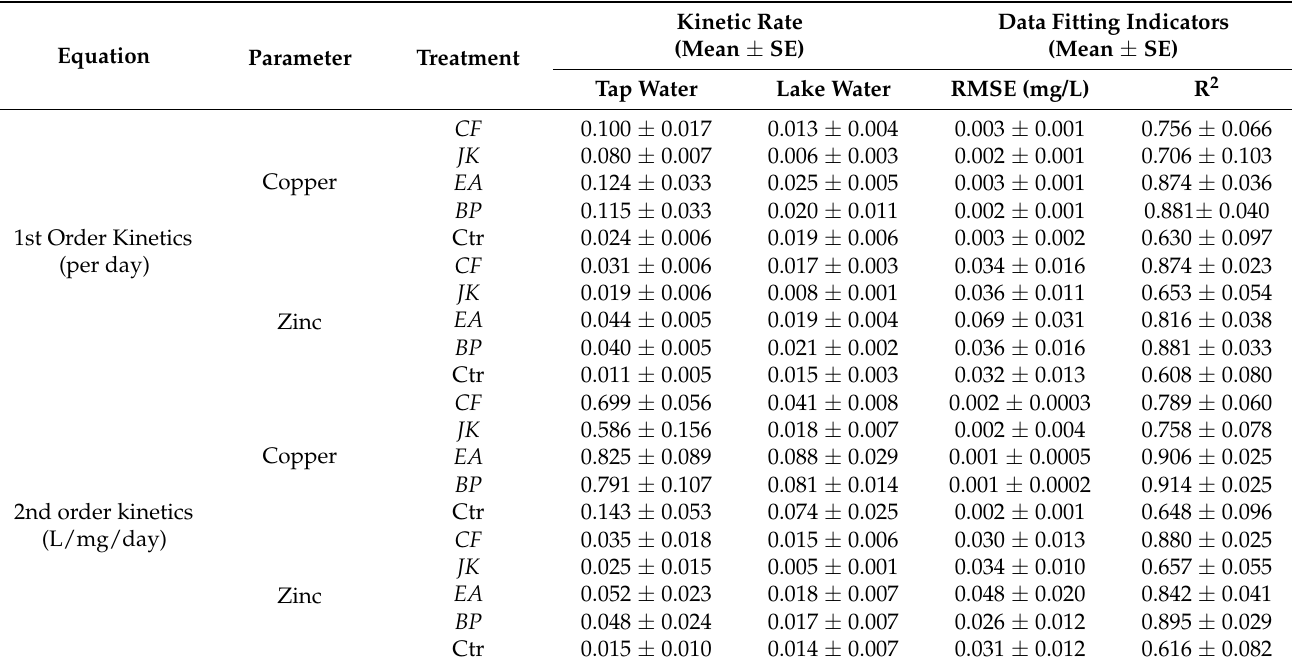
Table 3. Kinetic analysis of metal